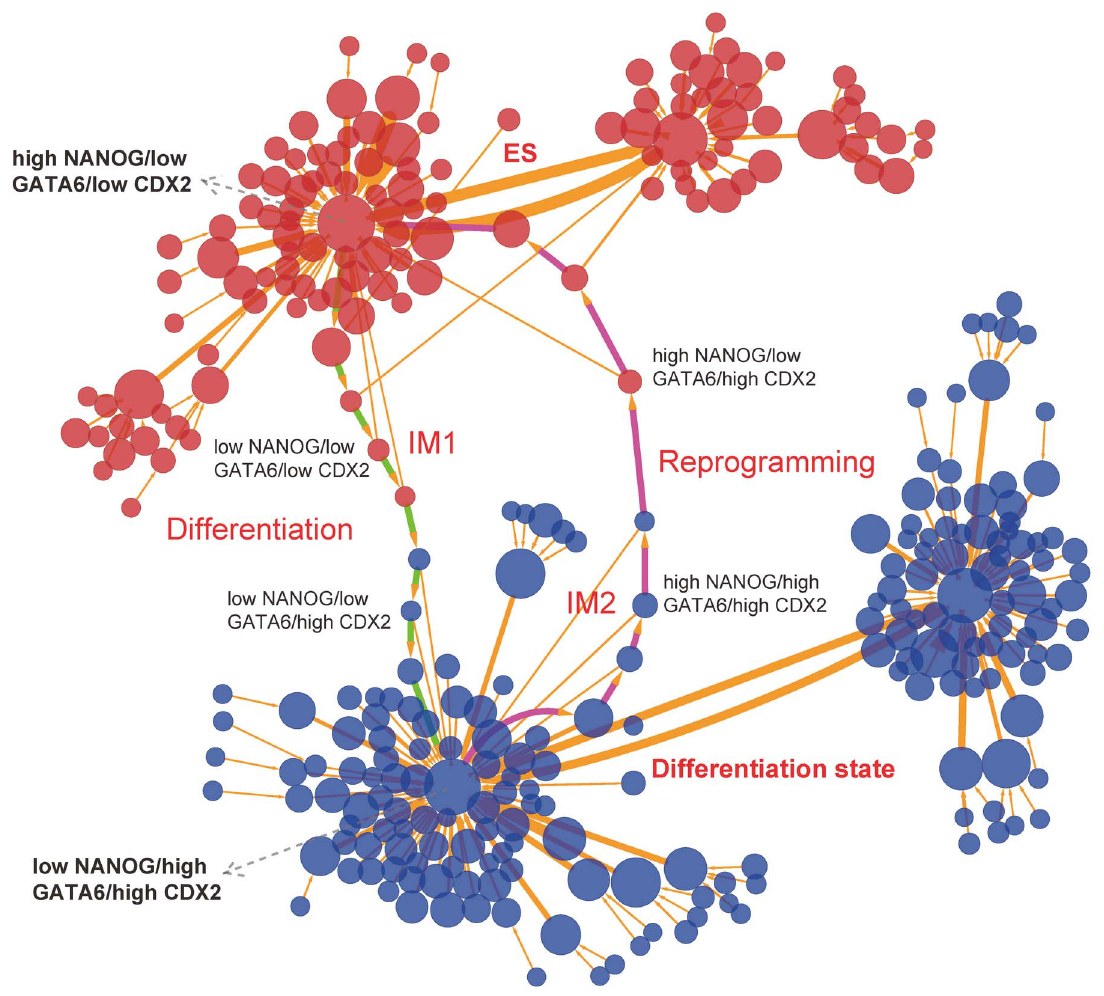
Figure 3. Differentiation and reprogramming process represented by 313 nodes (every node denotes a cell state, characterized by expression patterns of the 22 marker genes) and 329 edges (paths). The sizes of nodes and edges are proportional to the occurrence probability of the corresponding states and paths, respectively. Red nodes represent states which are closer to stem cell states in terms of gene expression pattern, and blue nodes represent states which are closer to differentiation states. The green and magenta paths denote dominant kinetic paths from path integral separately for differentiation and reprogramming. Here, we set a probability cutoff to decrease the number of states and paths, i.e. we only demonstrate the states and paths with higher probability. The largest red node (high NANOG/low GATA6/low CDX2) represents most major ES state (stem cell state), and the largest blue node (low NANOG/high GATA6/high CDX2) represents most major differentiation state. IM1 represents a intermediate state (low NANOG/low GATA6/low CDX2), and IM2 represents another intermediate state (high NANOG/high GATA6/high CDX2).